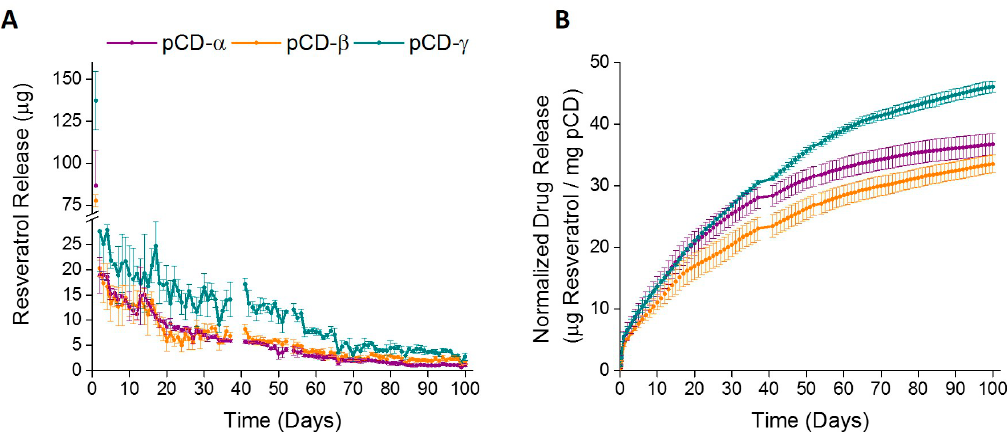
Figure 2. Polymerized cyclodextrin disks give long-term resveratrol release in vitro. ( A ) Alpha, Beta and Gamma pCD types displayed a small burst followed by a sustained release up to 100 days. Gamma-CD polymer exhibited the highest amount of total resveratrol released and a higher resveratrol release at all time points. ( B ) Release of resveratrol from pCD disks, normalized to CD polymer weight. Daily release of resveratrol from pCD disks displayed steadily decreasing daily dosage over 100 days of release.